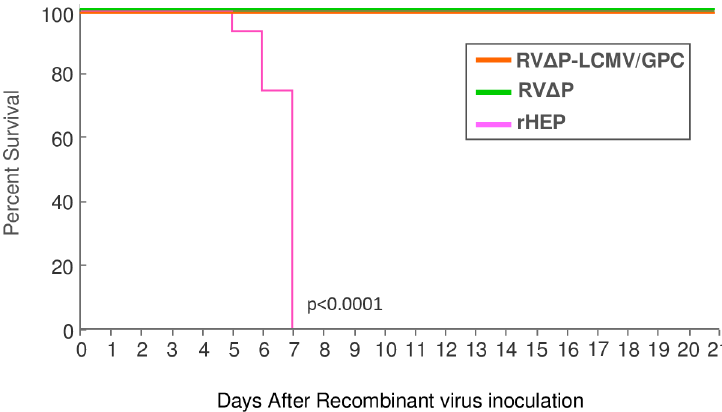
Fig 4. Safety profile of RV Δ P-LCMV/GPC. Suckling mice (4-day old) were inoculated with RV Δ P-LCMV/GPC (Orange), RV Δ P (Green), or rHEP (Pink) by intracerebral inoculation and observed for 3 weeks. Euthanasia was performed when the mouse was considered to have reached a moribund stage. Number of mice in each group was